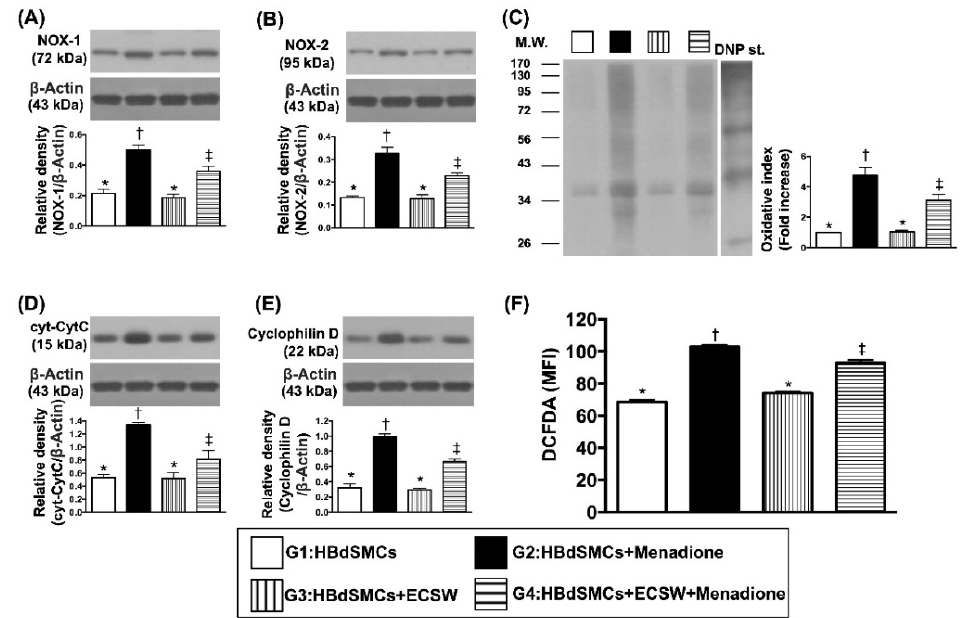
Figure 1. ECSW therapy protected the rat bladder smooth muscle cells (RBdSMCs) against oxidative stress and mitochondrial damage. ( A ) Protein expression of NXO-1, * vs. other groups with different symbols (†, ‡), p < 0.001. ( B ) Protein expression of NOX-2, * vs. other groups with different symbols (†, ‡), p < 0.001. ( C ) The oxidized protein expression, * vs. other groups with different symbols (†, ‡), p < 0.001 (Note: The left and right lanes shown on the upper panel represent protein molecular weight marker and control oxidized molecular protein standard, respectively). M.W. = molecular weight; DNP = 1–3 dinitrophenylhydrazone. ( D ) Protein expression of cytosolic cytochrome C (cyt-CytC), * vs. other groups with different symbols (†, ‡), p < 0.001. ( E ) Protein expression of cyclophilin D (cyc-D), * vs. other groups with different symbols (†, ‡), p < 0.001. ( F ) Flow cytometric analysis of mean fluorescent intensity (MFI) of DCFDA [i.e., reactive oxygen species (ROS)], * vs. other groups with different symbols (†, ‡), p < 0.001. All statistical analyses were performed by one-way ANOVA, followed by Bonferroni multiple comparison post hoc test ( n = 6 for each group). Symbols (*, †, ‡) indicate significance (at 0.05 level). ECSW = extracorporeal shock wave; RBdSMCs = rat bladder smooth muscle cells.